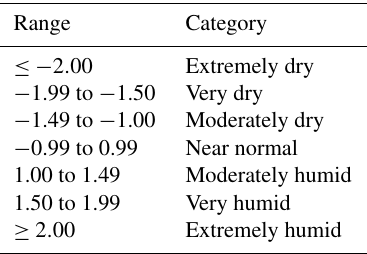
Table 1. Categories resulting from SPDI estimation, adapted from McKee et al.